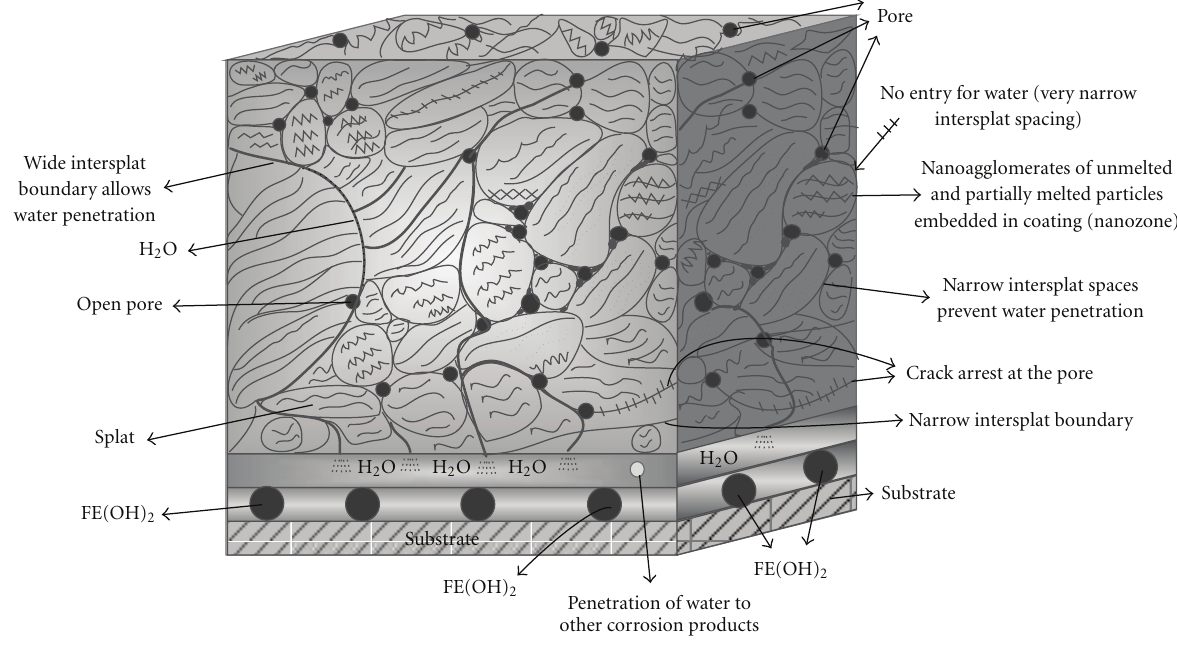
Figure 5: Erosion-corrosion phenomenon in nanostructured coating.